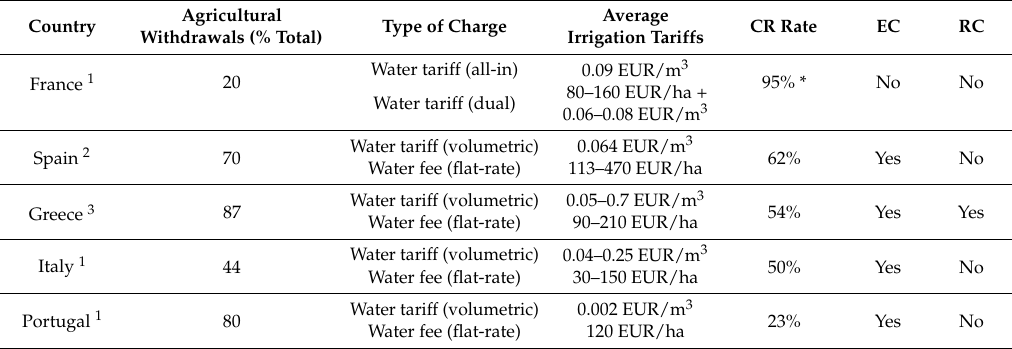
Table 1. Water provision charges and CR in agriculture for certain EU